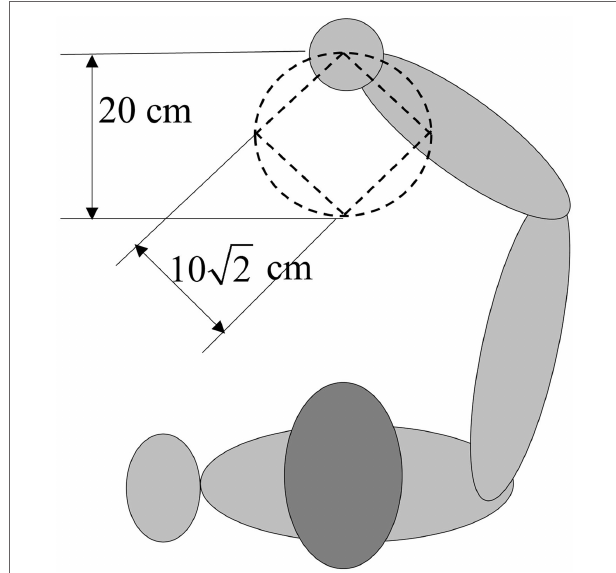
FIGURE 2 | Predefined square-shaped and circle-shaped trajectories in experiments. The side length of square-shaped trajectory is 0.1 the radius of the circle is 0.1m.